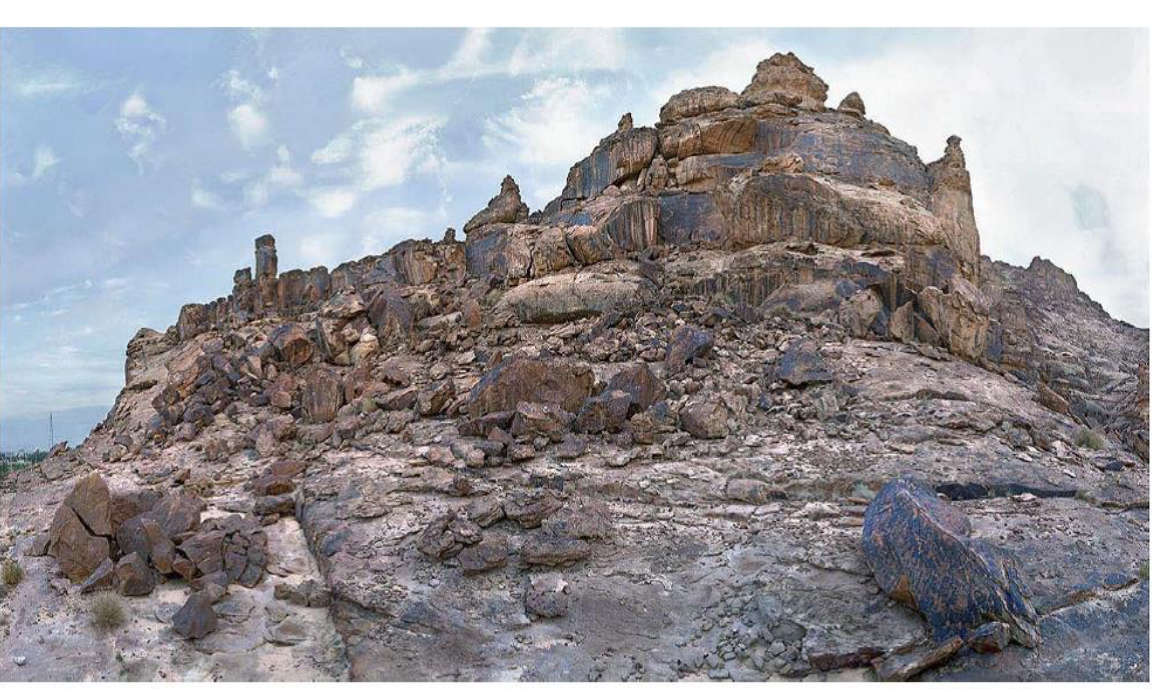
Figure 17. The most fascinating rock art site at Jabal Umm Sanman, Jubbah, Northern Arabia.